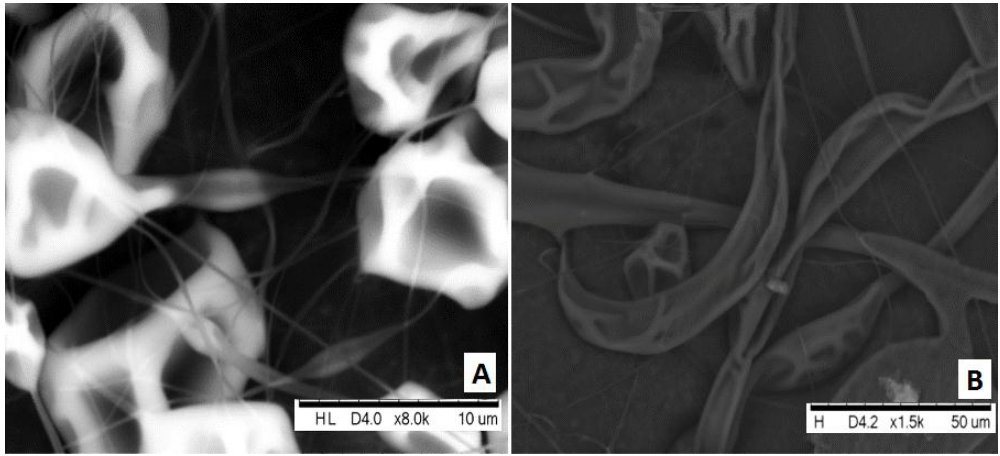
Figure 4. SEM images of electrospun fibers of 14 wt. % PEI without any additives at 20 kV, 20 cm and 10 µL/min.